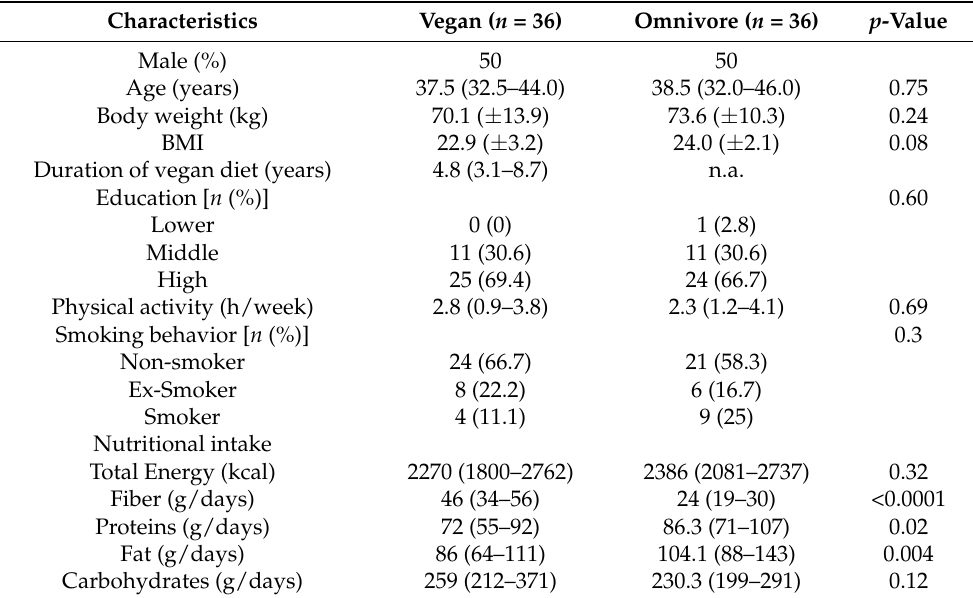
Table 1. Characteristics and nutritional intake of RBVD population.